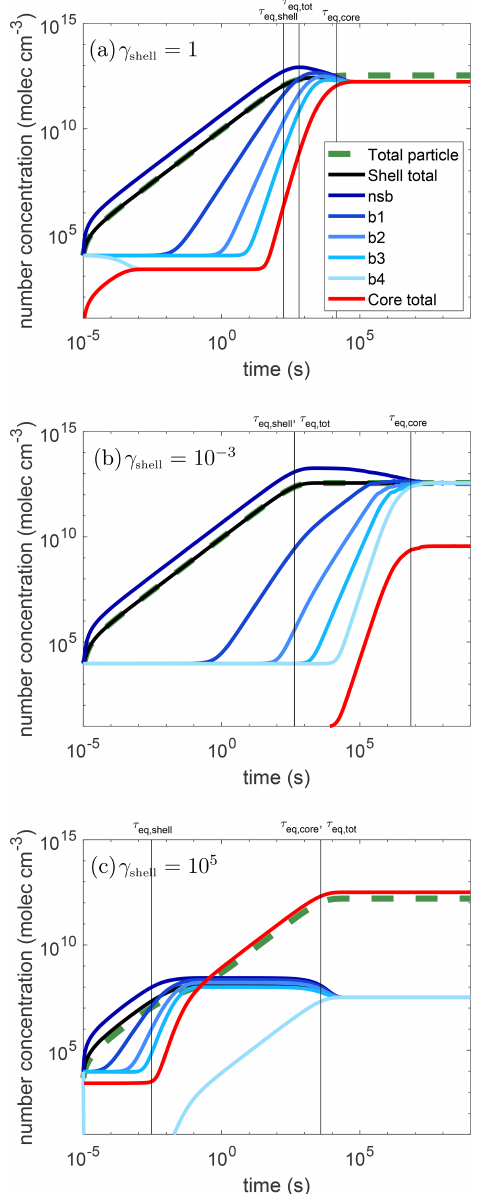
Figure 2. Temporal evolution of partitioning of semi-volatile species ( C 0 = 10µgm − 3 ) into core–shell particles with the core phase being liquid and the shell phase being semisolid with a bulk diffusivity of D b , shell = 10 − 16 cm 2 s − 1 . The activity coefficients of the condensing species in the shell phase are set to be (a) γ shell = 1, (b) γ shell = 10 − 3 , and (c) γ shell = 10 5 . The activity coefficients of the condensing species in the core phase are set to be 1 for all cases. The green dashed line is the concentration in the whole particle and the red line shows the concentration in the core. The blue lines show the concentration in each shell layer, getting progressively lighter in color from the near-surface bulk layer to the innermost shell layer (near-surface bulk, b 1 –b 4 ). The black line is the average concen- tration in the shell. The vertical black lines show the equilibrium timescales for the shell ( τ eq , shell ), core ( τ eq , core ), and total particle ( τ eq , tot